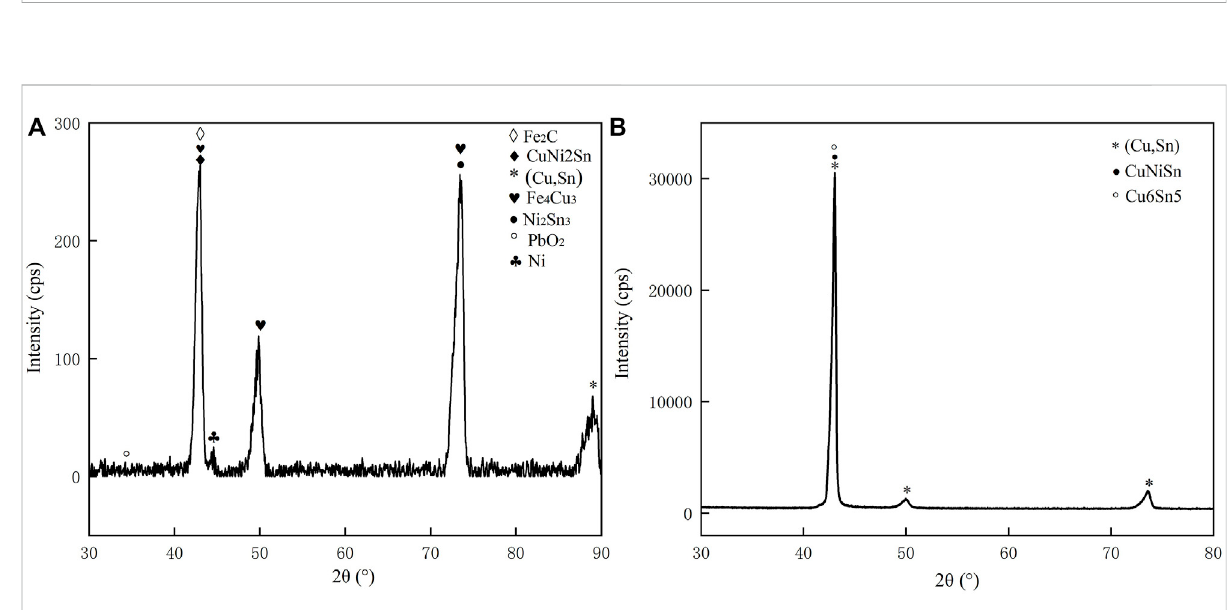
FIGURE 5 XRD analysis (A) alloy obtained by melting the circuit board (B) alloy obtained by pure metals.